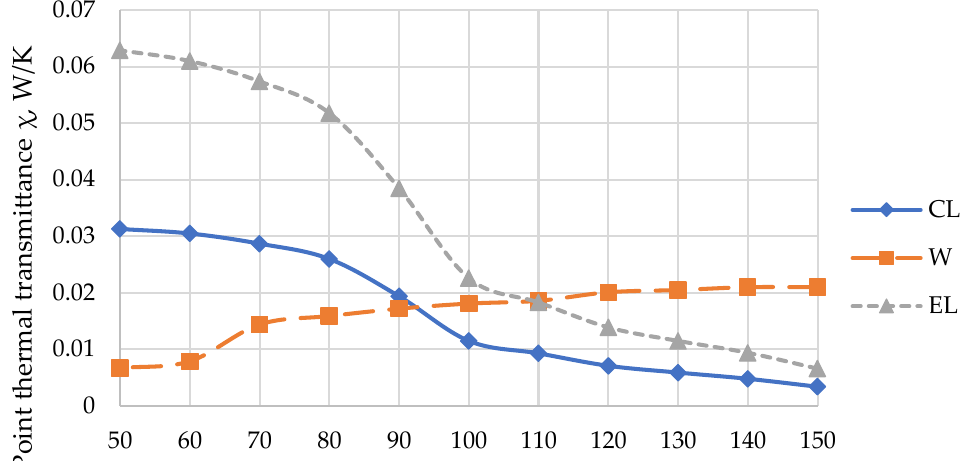
Figure 10. Dependence of the values of PTB on the window installation distance from the load-bearing layer edge for individual window mounting elements CL, EL, W.